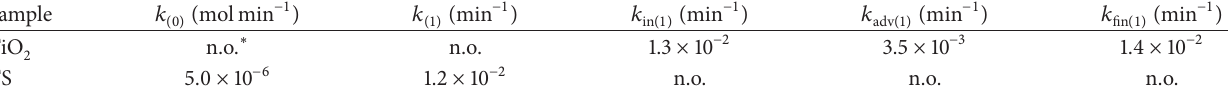
Table 1: Kinetic constants of TiO Sample